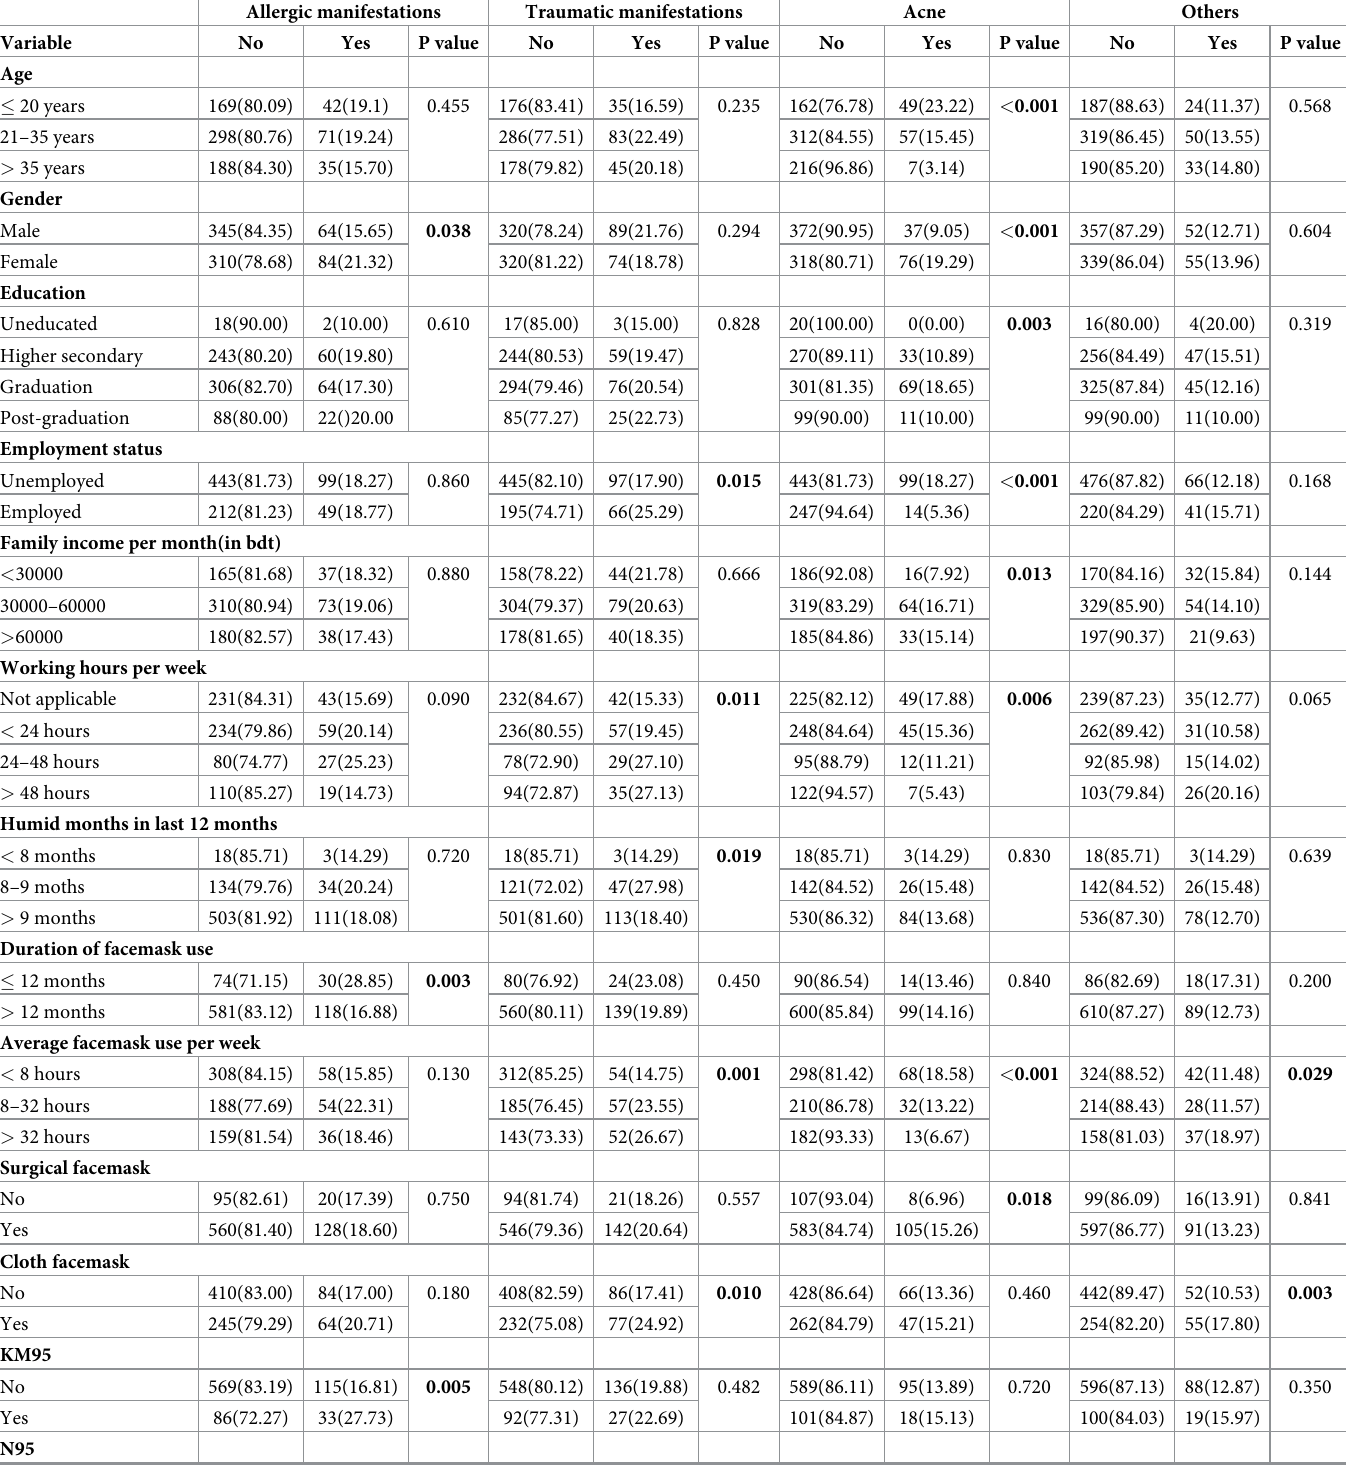
Table 2. Facemask use related skin manifestations and associated factors (N =